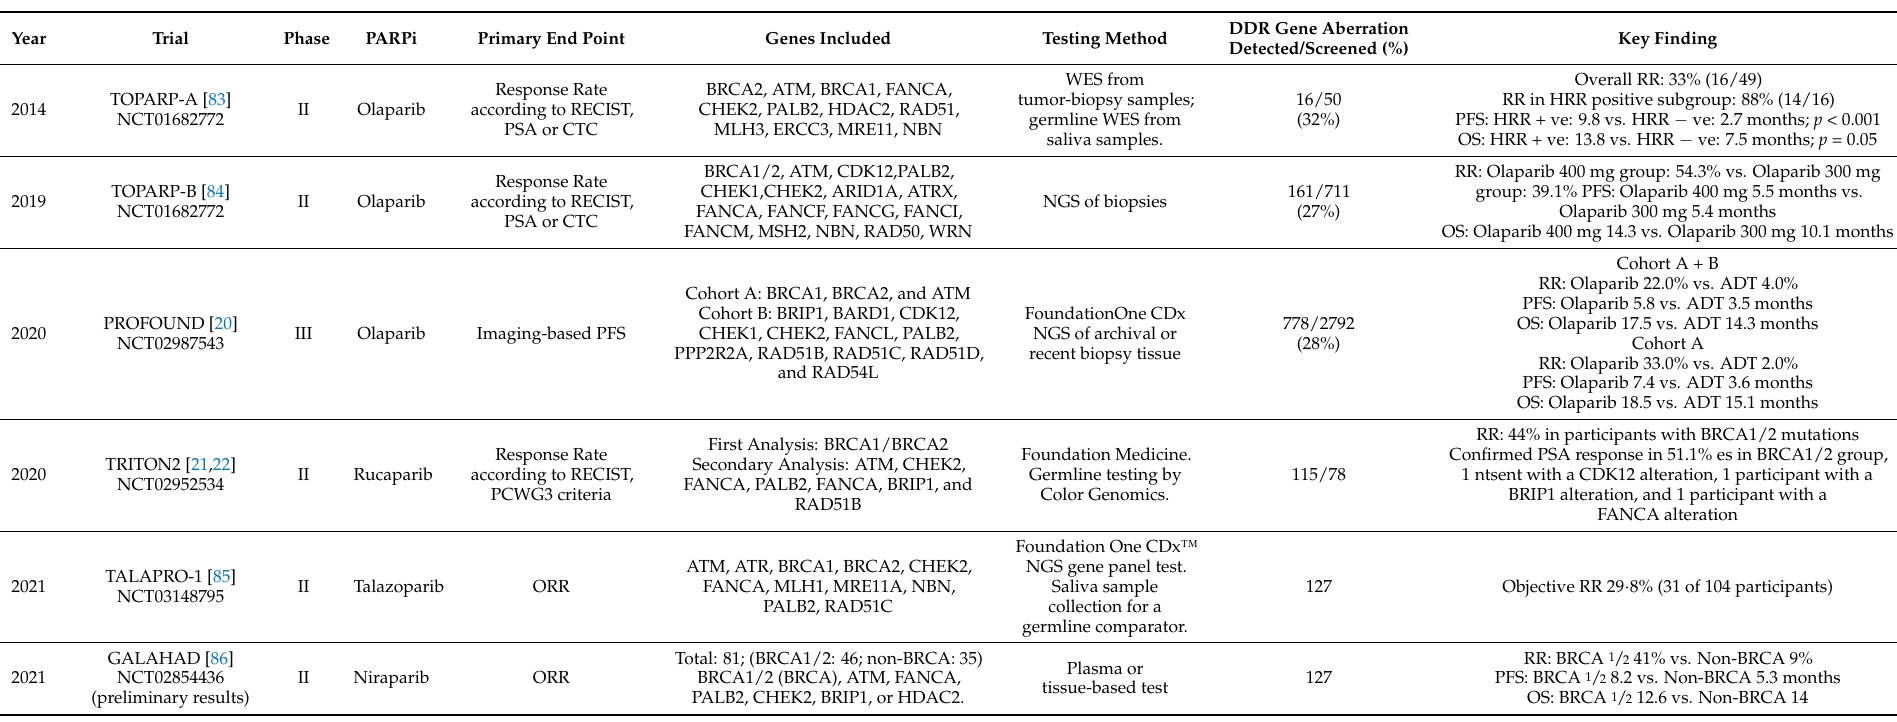
Table 5. PARPi Trials for Treatment for